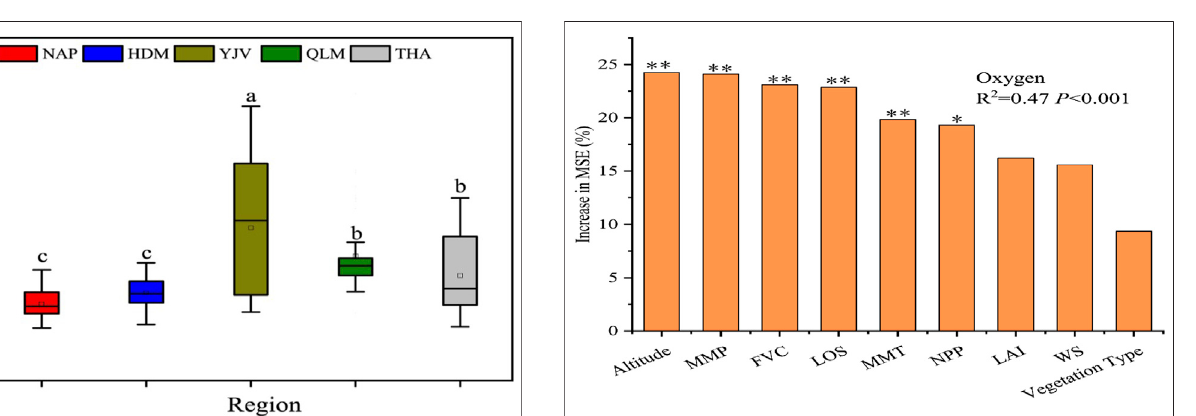
FIGURE 2 | The difference in atmospheric oxygen content among differentregions.Forindividualplots,nonmatchinglettersindicateasigni fi cant difference between regions. NAP, Ngari Prefecture; HDM, Hengduan Mountains; YJV, Yajiang Valley; QLM, Qilian Mountains; THA, Three- River Headwater